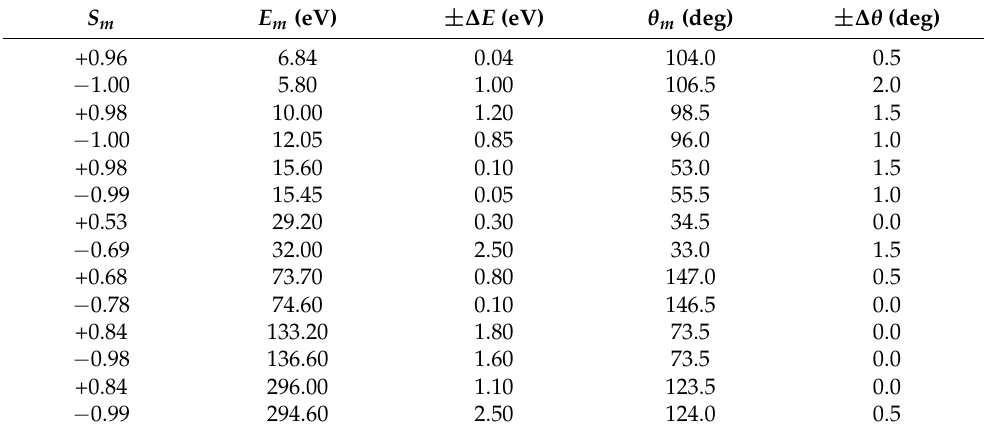
Table 2. Maximum spin polarization points, along with their positions and deviations in energy ∆ E and angle ∆ θ from their respective critical minima positions, for e − − Ni elastic scattering.